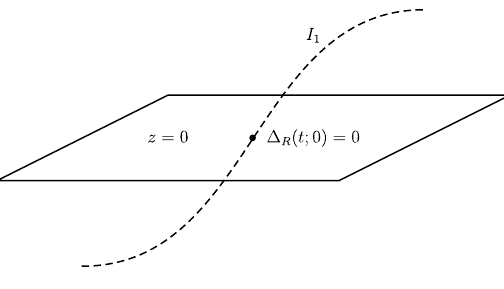
Figure 1 . An I 1 locus intersects the stack of 7-branes at z = 0.